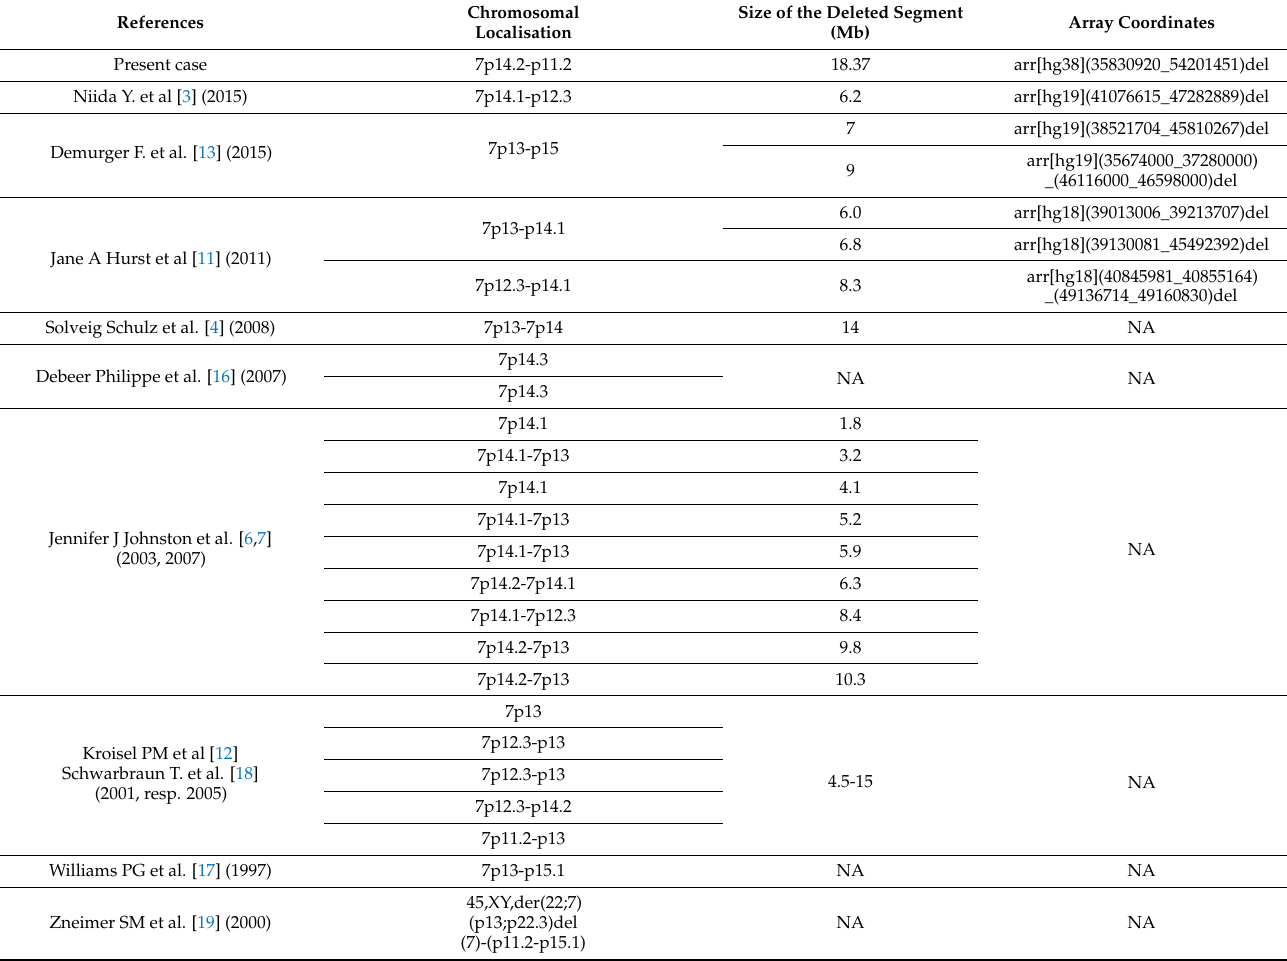
Table 2. Review of literature of the patients with GCP-CGS due to a chromosomal deletion encompassing GLI3 (>1